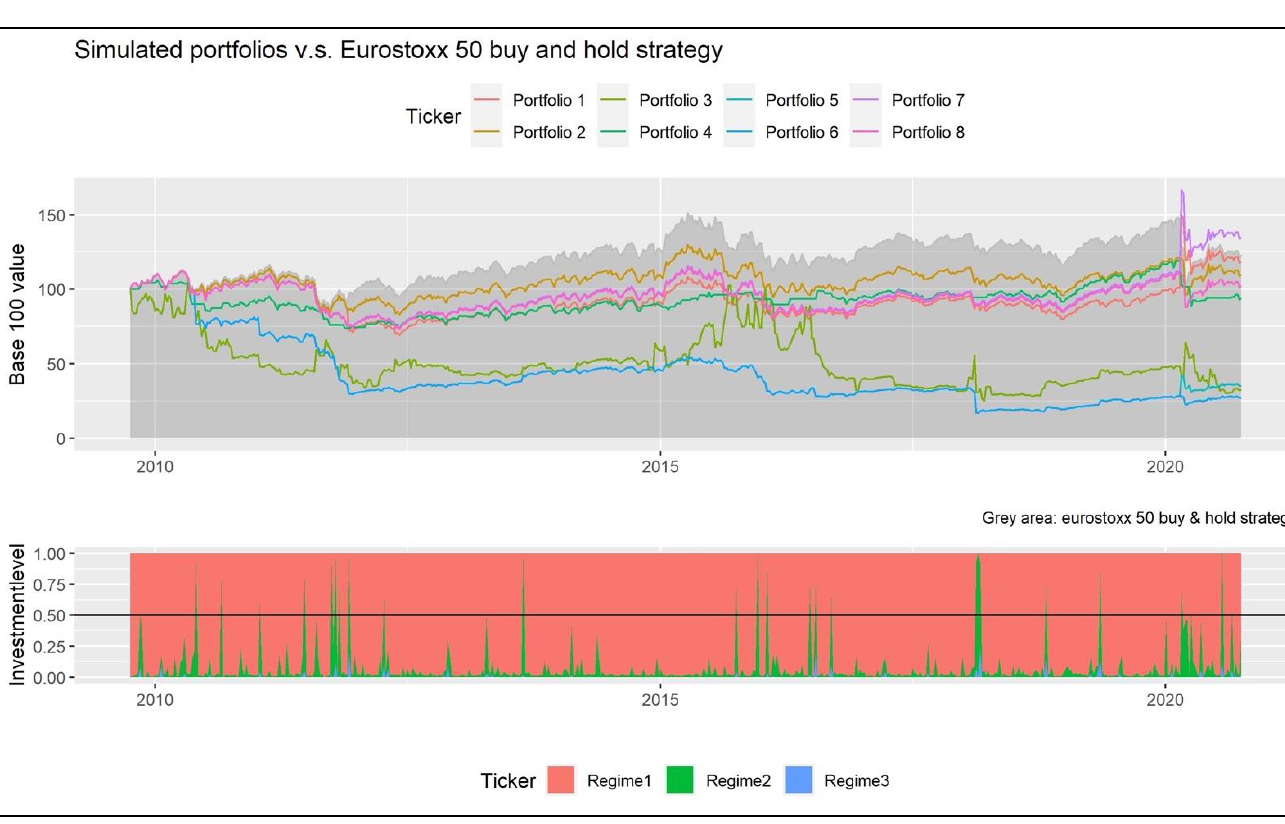
Figure 4. Weekly historical performance of the eight simulated portfolios of Table 2 with a fully invested weighting method ( 𝜔 𝑖 = 100% if 𝜉 𝑠=𝑖,𝑇+1 > 50% ). It presents the historical 9 July 2009 Base 100 value of the eight simulated portfolios (lines) against a buy-and-hold ESTOXX50 strategy (grey area). The historical three-regime MS-GARCH regime-specific forecasted smoothed probabilities ( 𝜉 𝑠=𝑖,𝑇+1,𝑡 ). Methodological note: The eight simulated portfolios include the impact of a stock-trading fee of 0.1% plus 10% VAT.